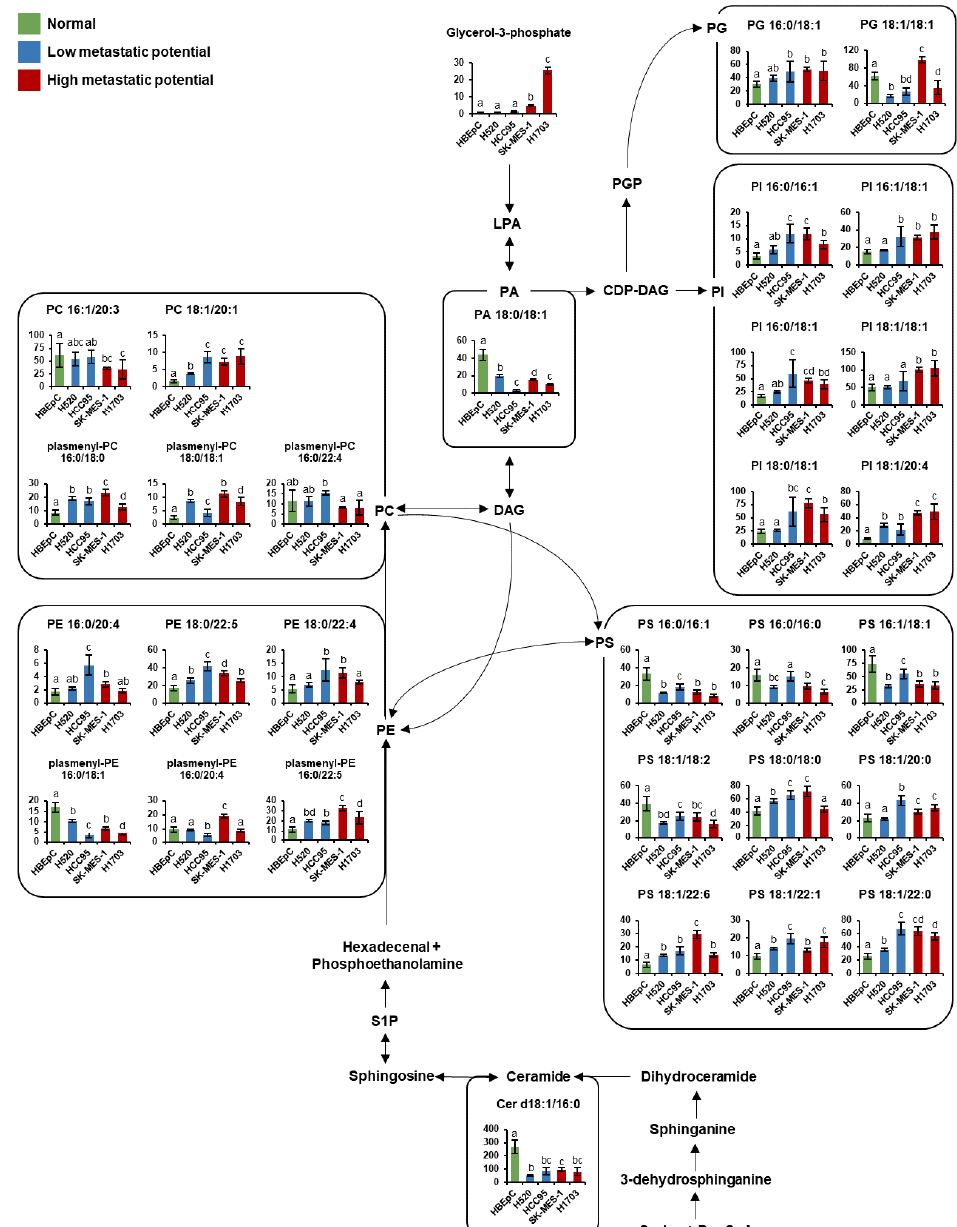
Figure 6. Schematic of lipid pathway in human bronchial epithelial cells (HBEpC) and four lung squamous cell carcinoma cell lines (H520, HCC95, SK-MES-1, and H1703). The indicated lipid pathways were modified from the KEGG database (http://www.genome.jp/kegg/ accessed on 5 March 2021). Indicated lipid species on the pathway were selected by each PLS-DA model with a VIP value over 1.0. Each graph shows mean values with error bars indicating SD ( n = 8, four biological replicates, and two technical replicates for each group). The Y -axis of each data represents the normalized peak intensity. Significant differences were evaluated using ANOVA with a Tukey’s post hoc test and different letters (a, b, c, and d) represent statistically significant differences of relative levels of each intact lipid among samples ( p < 0.05). Relative levels of each lipid were represented with different colors according to the cell’s metastatic potential (green, normal cells; blue, low-metastatic potential of lung SQCC; red, high-metastatic potential of lung SQCC). Cer, ceramide; CDP-DAG, cytidine diphosphate diacylglycerol; DAG, diacylglycerol; LPA, lysophosphatidic acid; PA, phosphatidic acid; PC, phosphatidylcholine; PE, phosphatidylethanolamine; PG, phosphatidylglycerol; PGP, phosphatidylglycerophosphate; PI, phosphatidylinositol; PS, phosphatidylserine; Pm-CoA; palmitoyl-CoA; S1P,